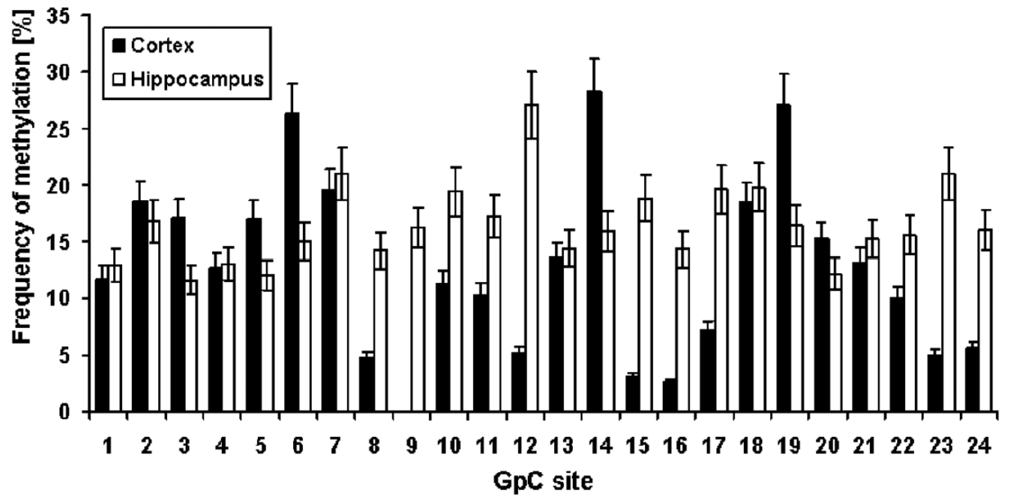
Figure 2. Frequency of DNA methylation at 24 CpG sites, located in the ( 2 456/ 2 255) region of the ACE gene in human post mortem samples of hippocampus and cortex from 13 control individuals.